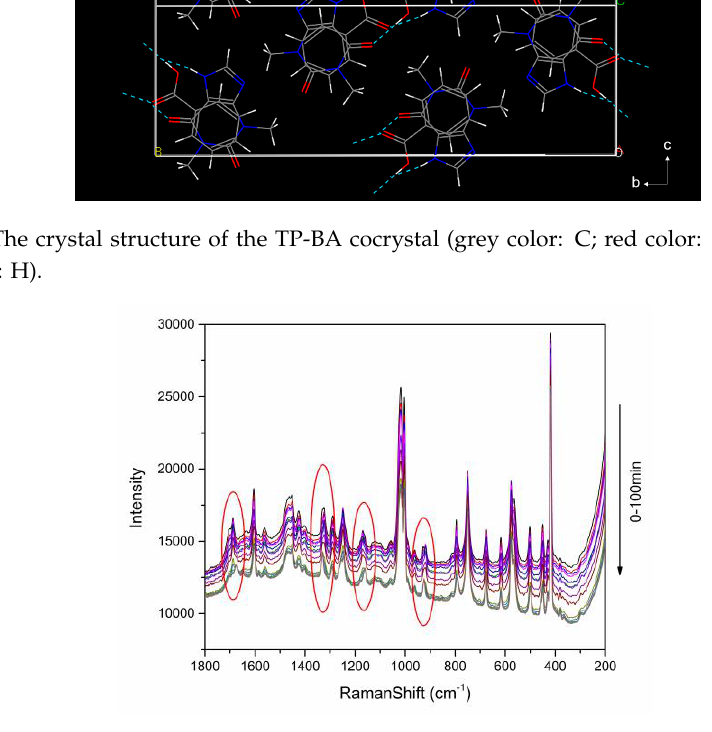
Figure 4. The variation of the Raman spectra of TP-BA cocrystal formation in slurry crystallization. The time intervals of the Raman spectra are listed in Table 2.